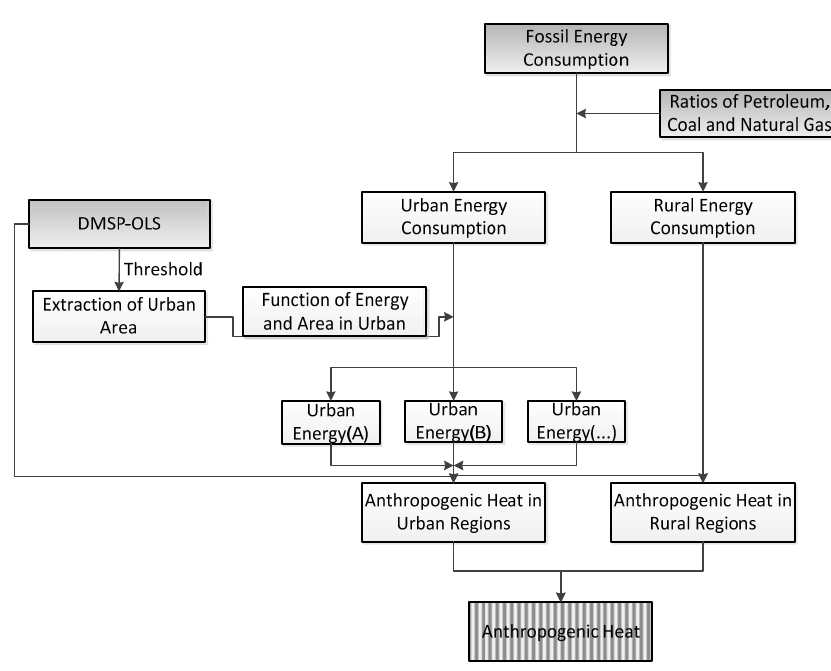
Figure 1. Diagram of estimation for AHF.